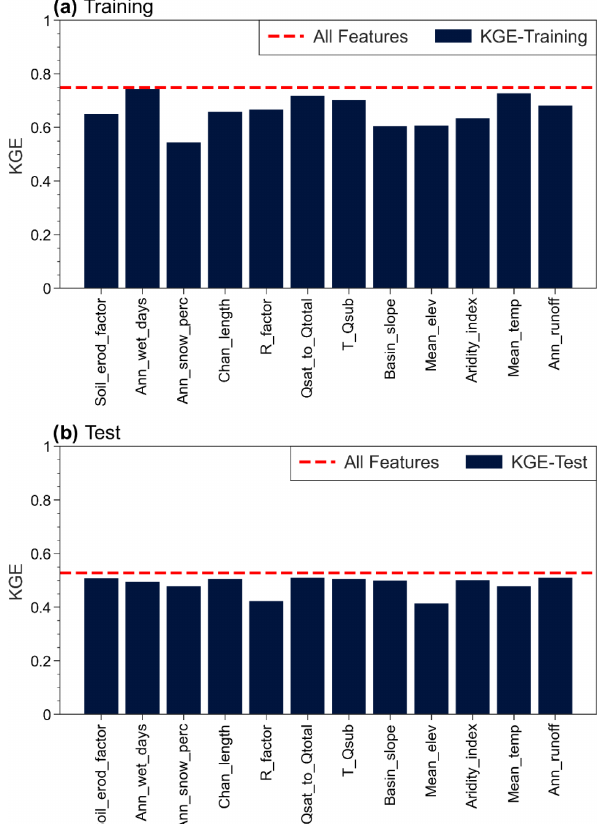
Figure 7. Sensitivity of the XGBoost model to the selected features. The result shown in blue bars are obtained by dropping the corre- sponding labeled feature from the 13 selected features. The dashed red line represents the model performance with all